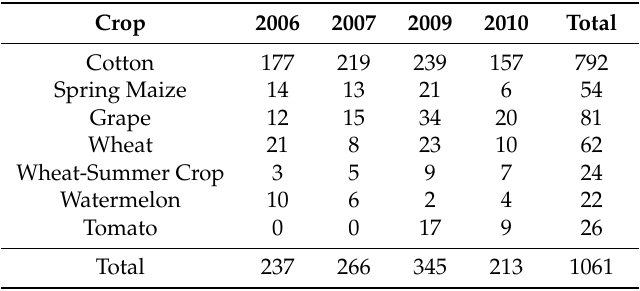
Figure 3. Procedure of collecting the historical reference data: ( a ) The distribution of sampling frames; ( b ) one of the 1 km by 1 km frames; ( c ) crop field boundaries of a frame; and ( d ) select MODIS pixels